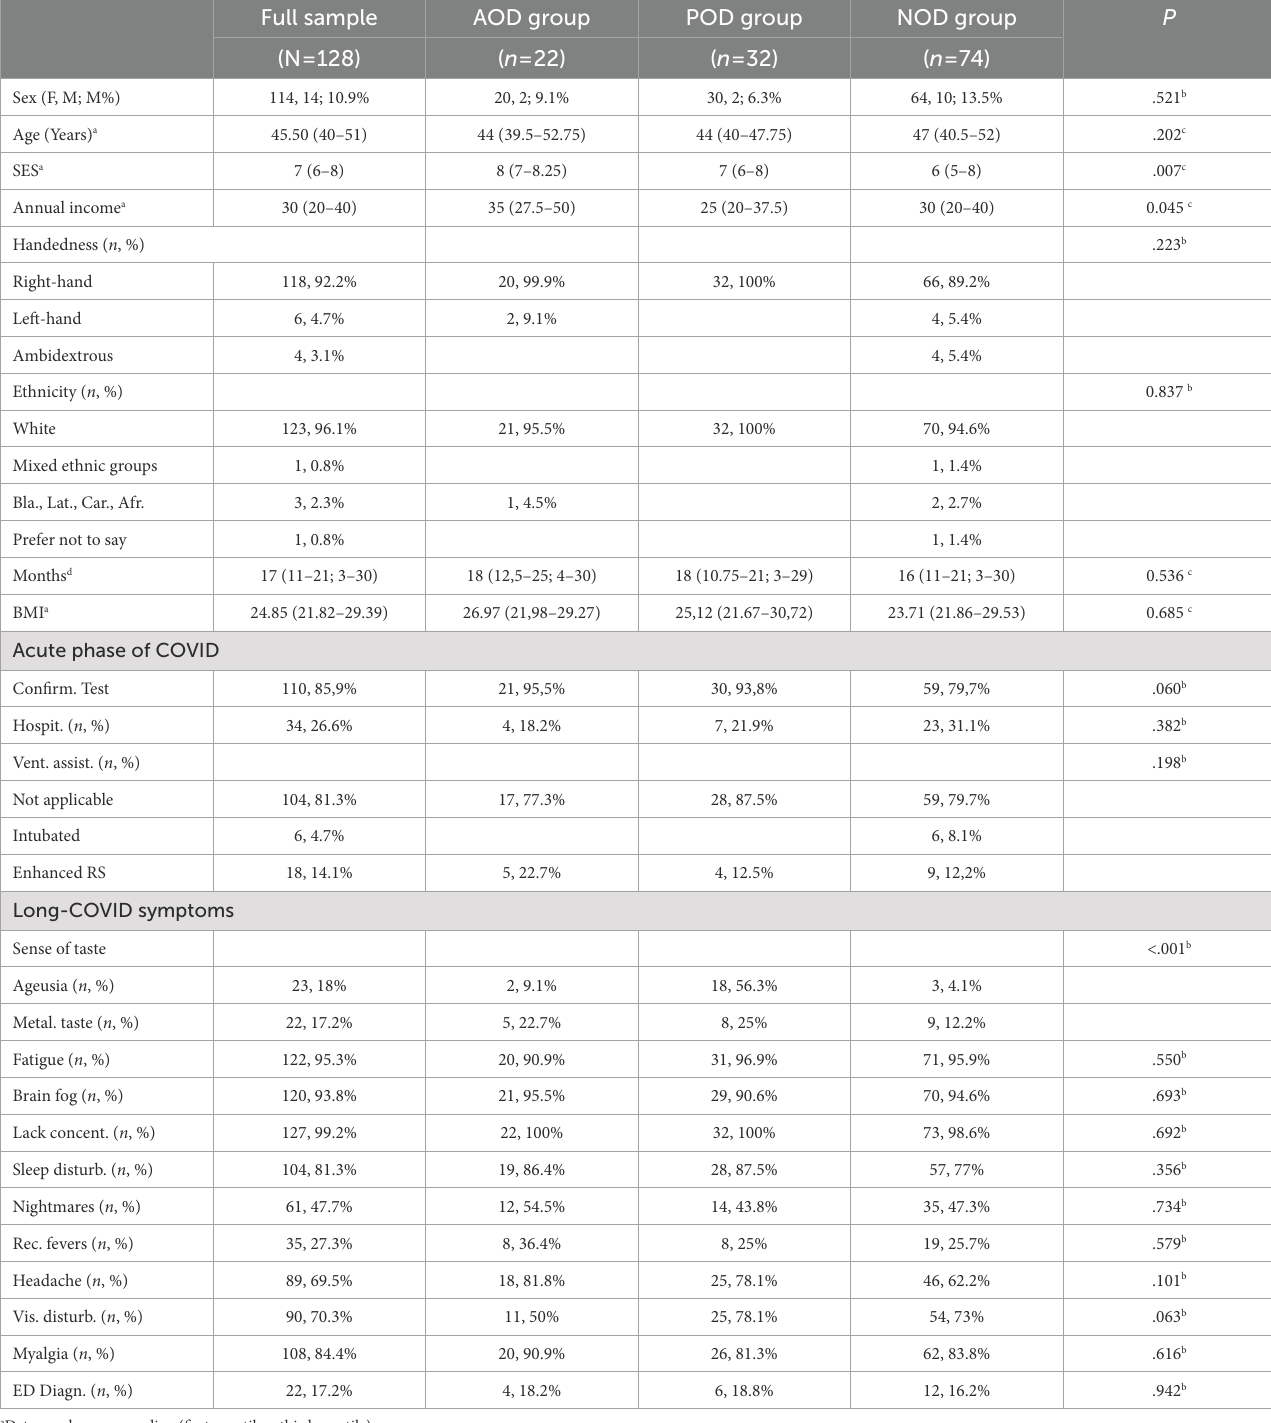
TABLE 1 Demographic information and clinical characteristics of the full sample related to the COVID history in the AOD, POD, and NOD groups. Full sample AOD